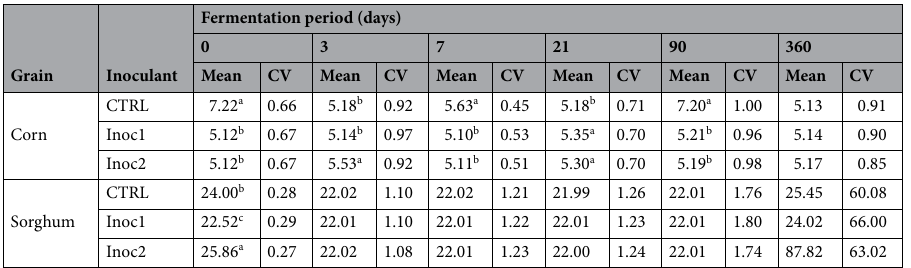
Fermentation period